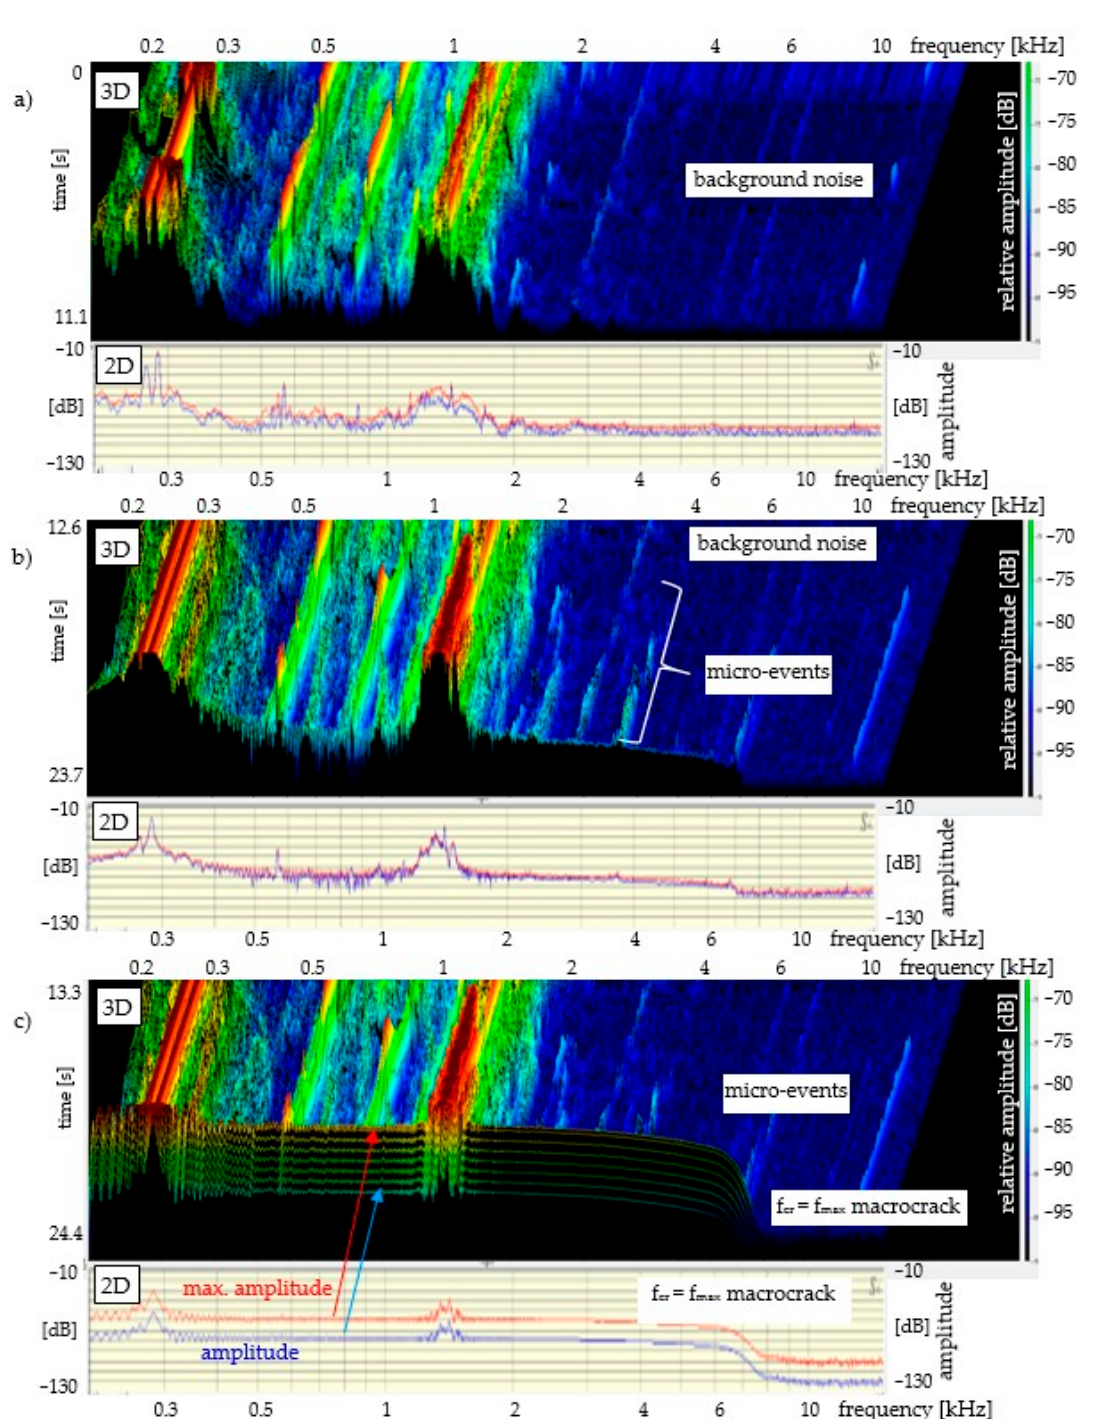
Figure 4. Mortar without reinforcement: bending test—AE; sound spectrum 3D and 2D: ( a ) background noise; ( b ) micro- events; ( c ) micro-events and macrocrack f cr = f max .